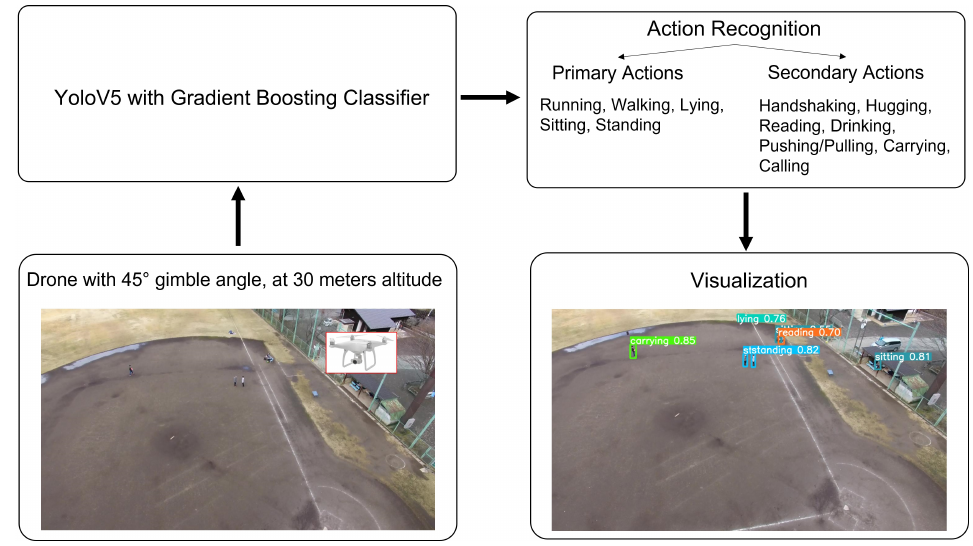
Figure 1. Overview of pipeline of work. First, the flying drone with a camera captures the im- ages of the scene, which are input into the YoloV5 detector in an offline process. The gradient boosting classifier makes weight adjustments for difficult samples and re-trains the model for final action detection.